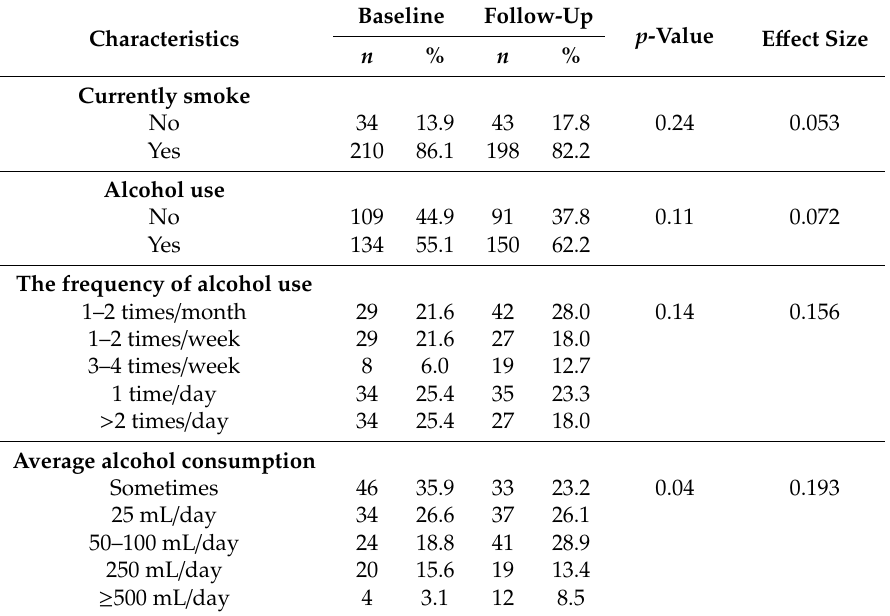
Table 3. Changes in alcohol use and smoking among methadone maintenance treatment